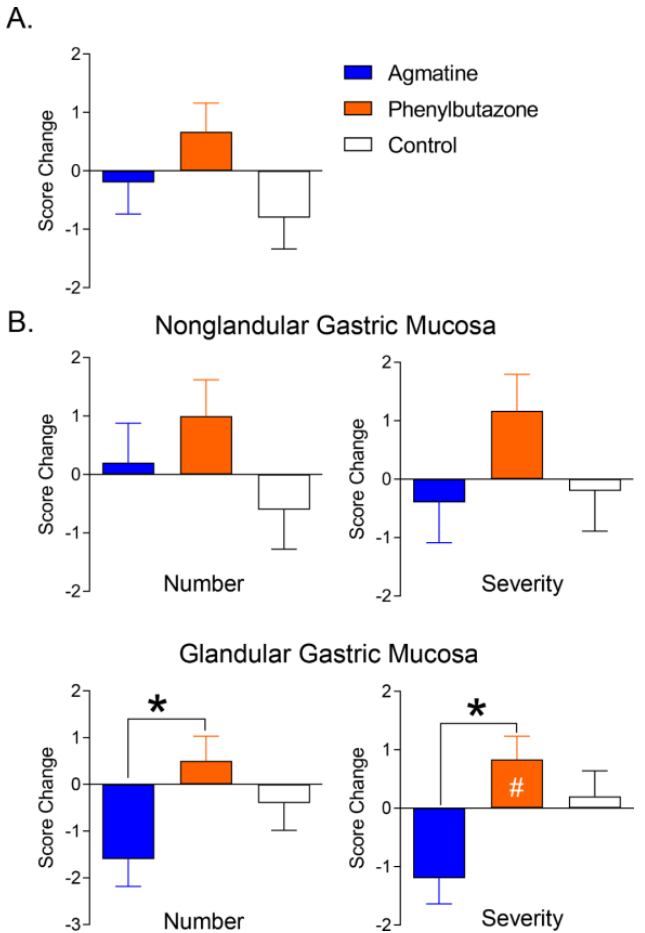
after phenylbutazone administration (Figure 5 and Table 8). Additionally, glandular mucosa ulcer severity ( p = 0.0115) and number ( p = 0.0472) were lower after agmatine versus phenylbutazone administration. There were treatment effects of agmatine ( β = − 1.1444, p = 0.0063) and phenylbutazone ( β = 0.8889, p = 0.0204) on score changes in glandular number and severity (Table 9).